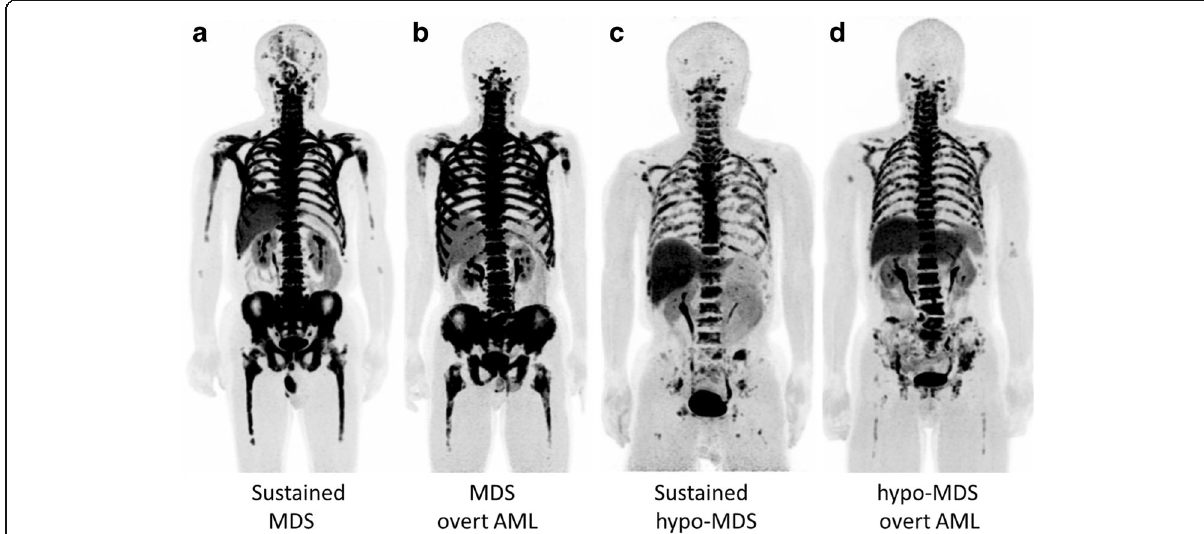
Fig. 5 Maximum intensity projection 18 F-FLT PET images of MDS patients ( a – d ). MDS patients exhibited marked 18 F-FLT uptake in the central skeleton and proximal extremities ( a , b ). On the other hand, hypo-MDS patients who were defined by having decreased 18 F-FLT uptake in the pelvis exhibited a slightly decreased uptake of the tracer in the vertebrae and ribs ( c , d ). 18 F-FLT PET did not reveal any significant differences between patients with sustained MDS or overt AML